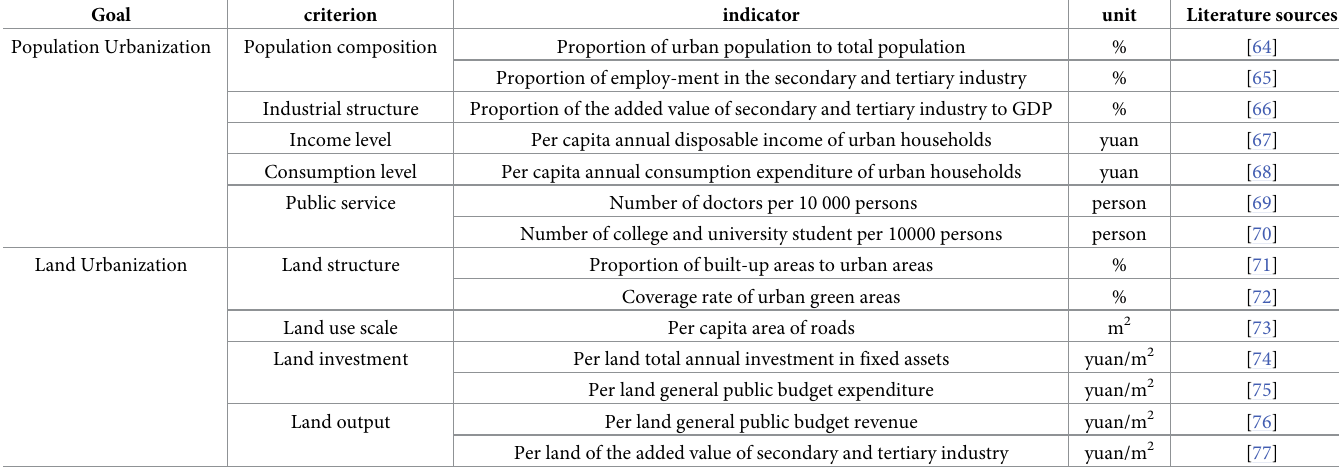
Table 1. Evaluation framework of the coordinated development of population-land